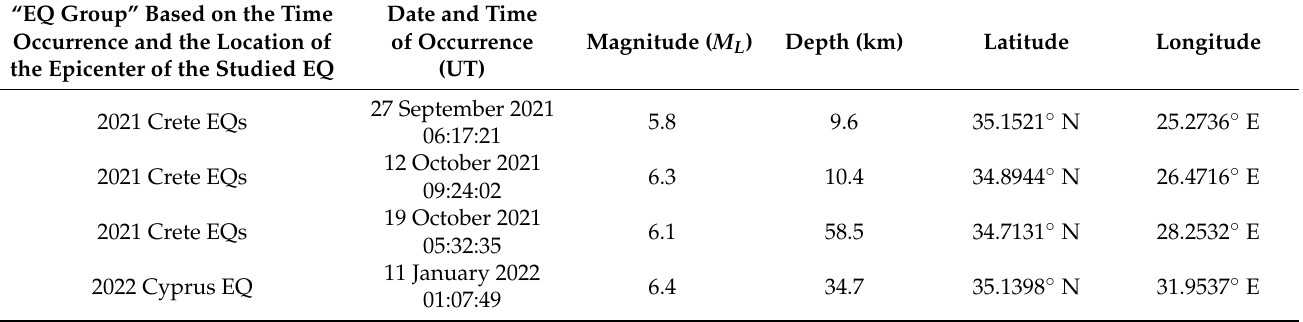
Table 1. List of examined EQs in the southeastern